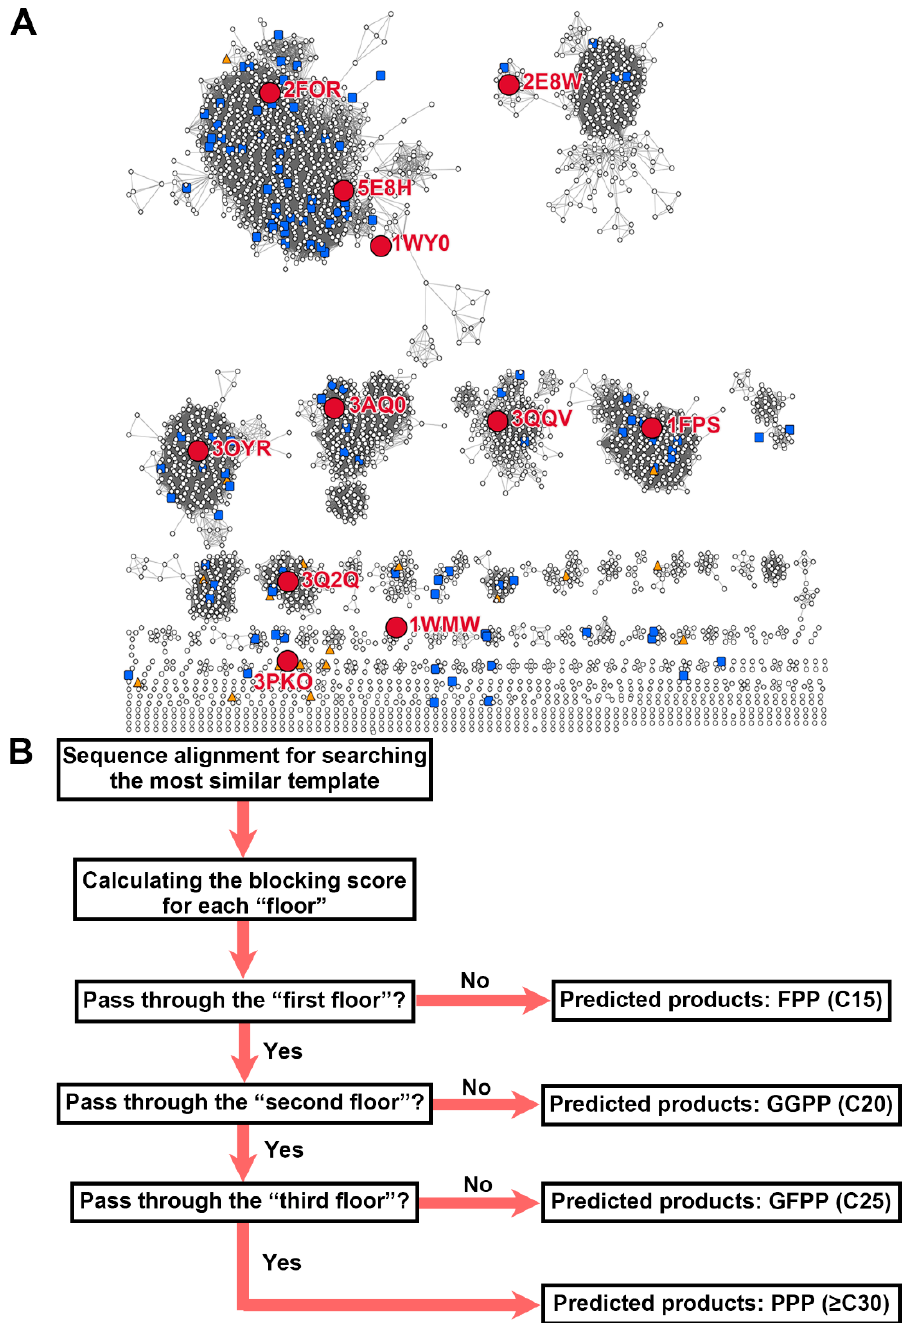
Figure 2. Sequence similarity network map of the trans- PT family and flowchart of PTS-Pre tool. ( A ) Sequence similarity network of the trans- PTs family with BLAST e-value cutoff set to 1e − 50 . Eleven representative trans- PTs (PDB IDs: 2FOR, 5E8H, 1WY0, 2E8W, 3OYR, 3AQ0, 3QQV, 1FPS, 3Q2Q, 3PKO, and 1WMW) are marked as large red circles. The incorrect and correct prediction cases from the experimentally determined testing dataset are marked as orange triangles and blue squares, respectively. ( B ) The general strategy followed by PTS-Pre for the functional prediction of trans- PTS. First, the target protein is aligned with each of the searching template sequences, and the best template with the highest sequence identity is selected as a reference for locating the six “floor” residues. Afterward, PTS-Pre calculates the “blocking score” for each “floor” on the basis of the types of amino acids and the parameter weights for each site. Finally, according to the “blocking scores”, PTS-Pre predicts the products’ chain length of target enzymes.